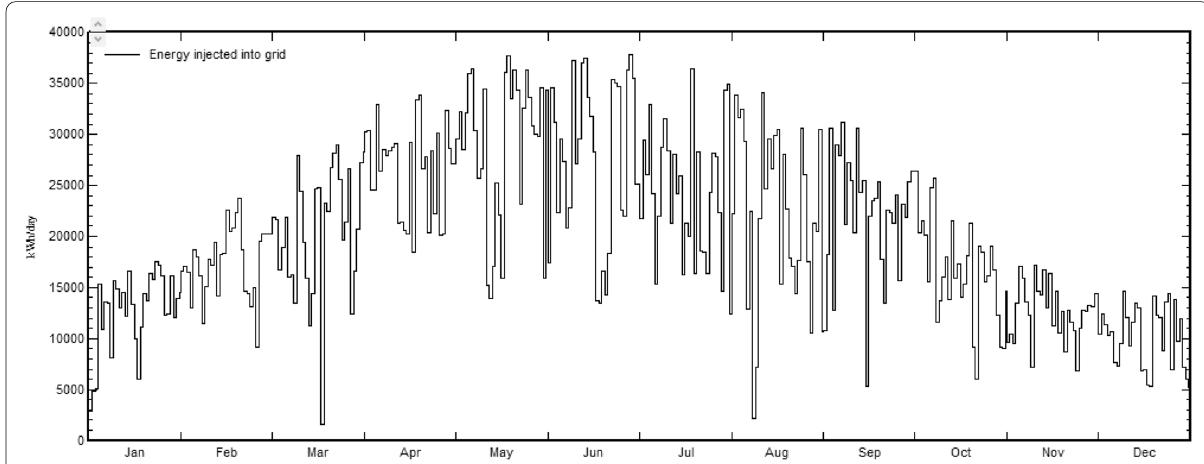
Fig. 11 Daily power generation curve of community